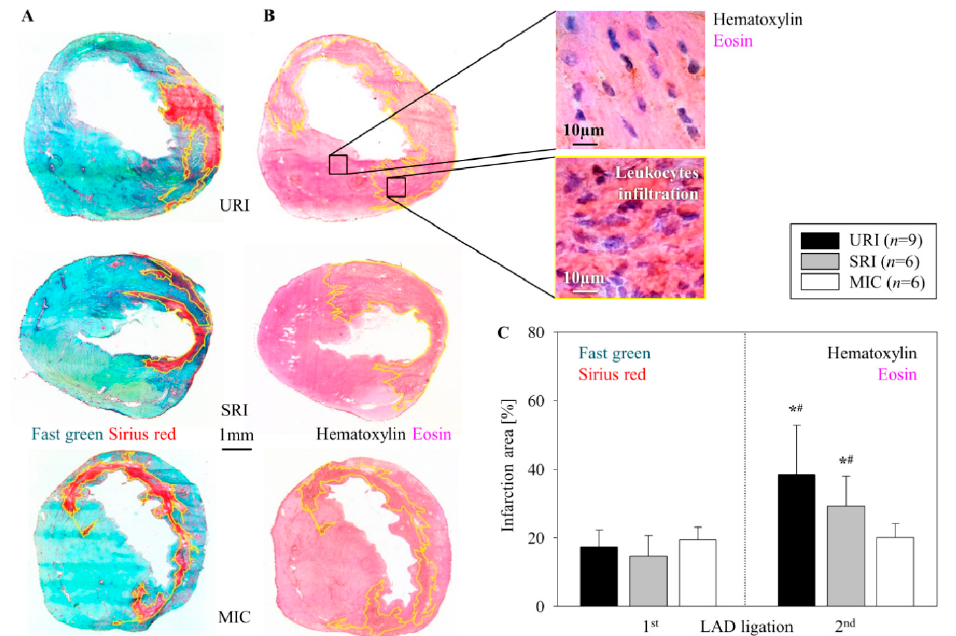
Figure 4. Alterations in MI size. Representative images show the infarction area (enclosed within the yellow border) for URI, SRI, and MIC 9 days after the first LAD ligation (Fast Green and Sirius Red staining) ( A ), as well as 48 h after the second LAD ligation (Hematoxylin and Eosin staining) ( B ). Significant increase of the infarction size after the second LAD ligation, mean ± SD, * P ≤ 0.009 as compared with the first LAD ligation, # P ≤ 0.041 in contrast to MIC (Mann–Whitney U test) ( C ).